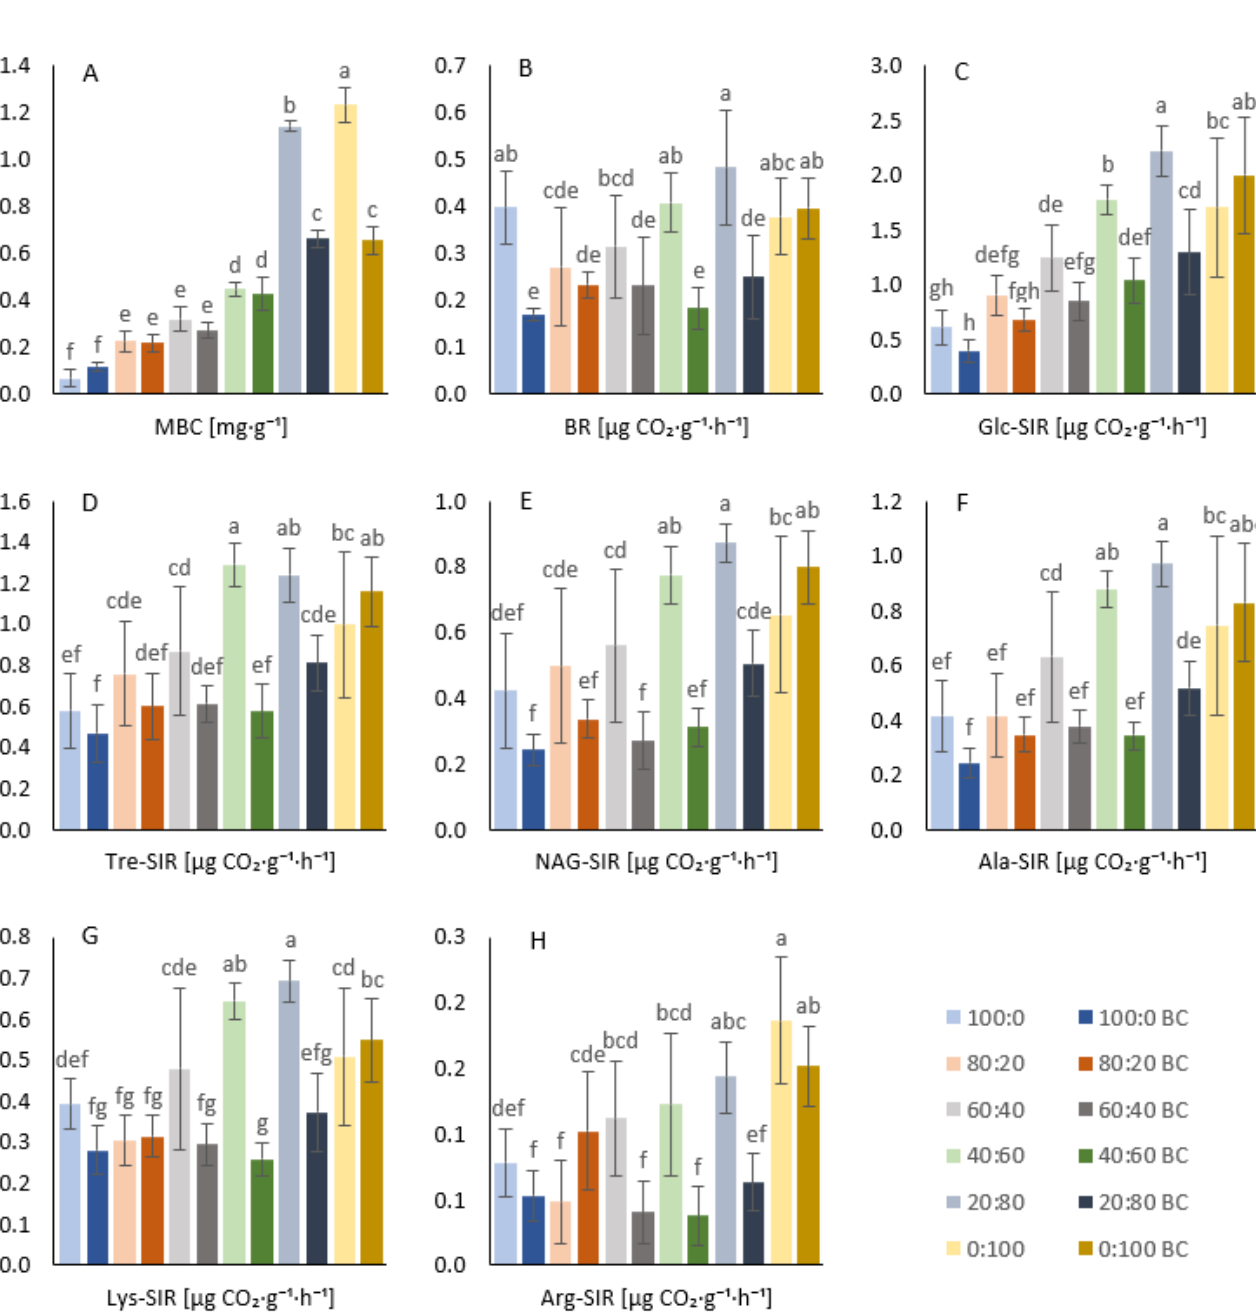
Figure 4. Microbial biomass carbon values ( A ). Soil basal values ( B ). Respiration induced by D-glucose ( C ), D-trehalose ( D ), N-acetyl- β -D-glucosamine ( E ), L-alanine ( F ), L-lysine ( G ), and L-arginine ( H ). Average values shown with standard error of mean (error bars), treatments amended with biochar (dark colors) and unamended (light colors) are sorted by decreasing sand:soil ratios (from 100:0 to 0:100). Different letters indicate statistically significant differences of MANOVA at p ≤ 0.05.